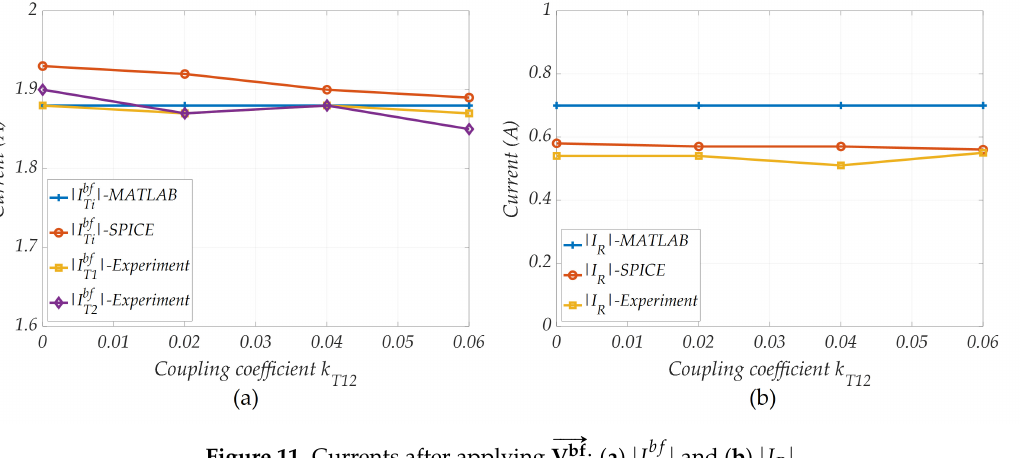
Figure 11. Currents after applying